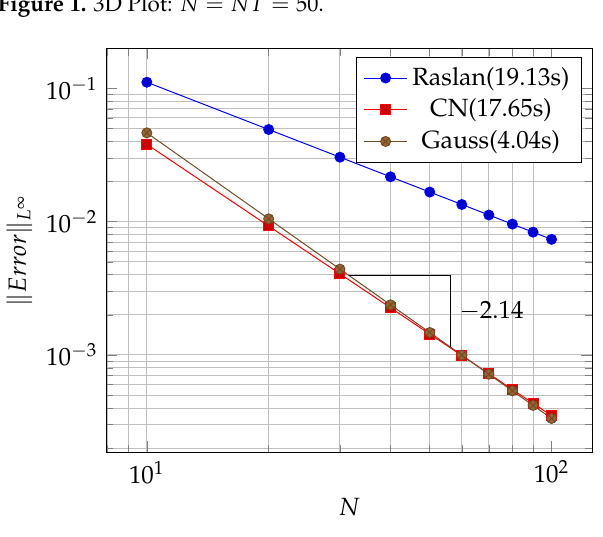
Figure 2. Convergence